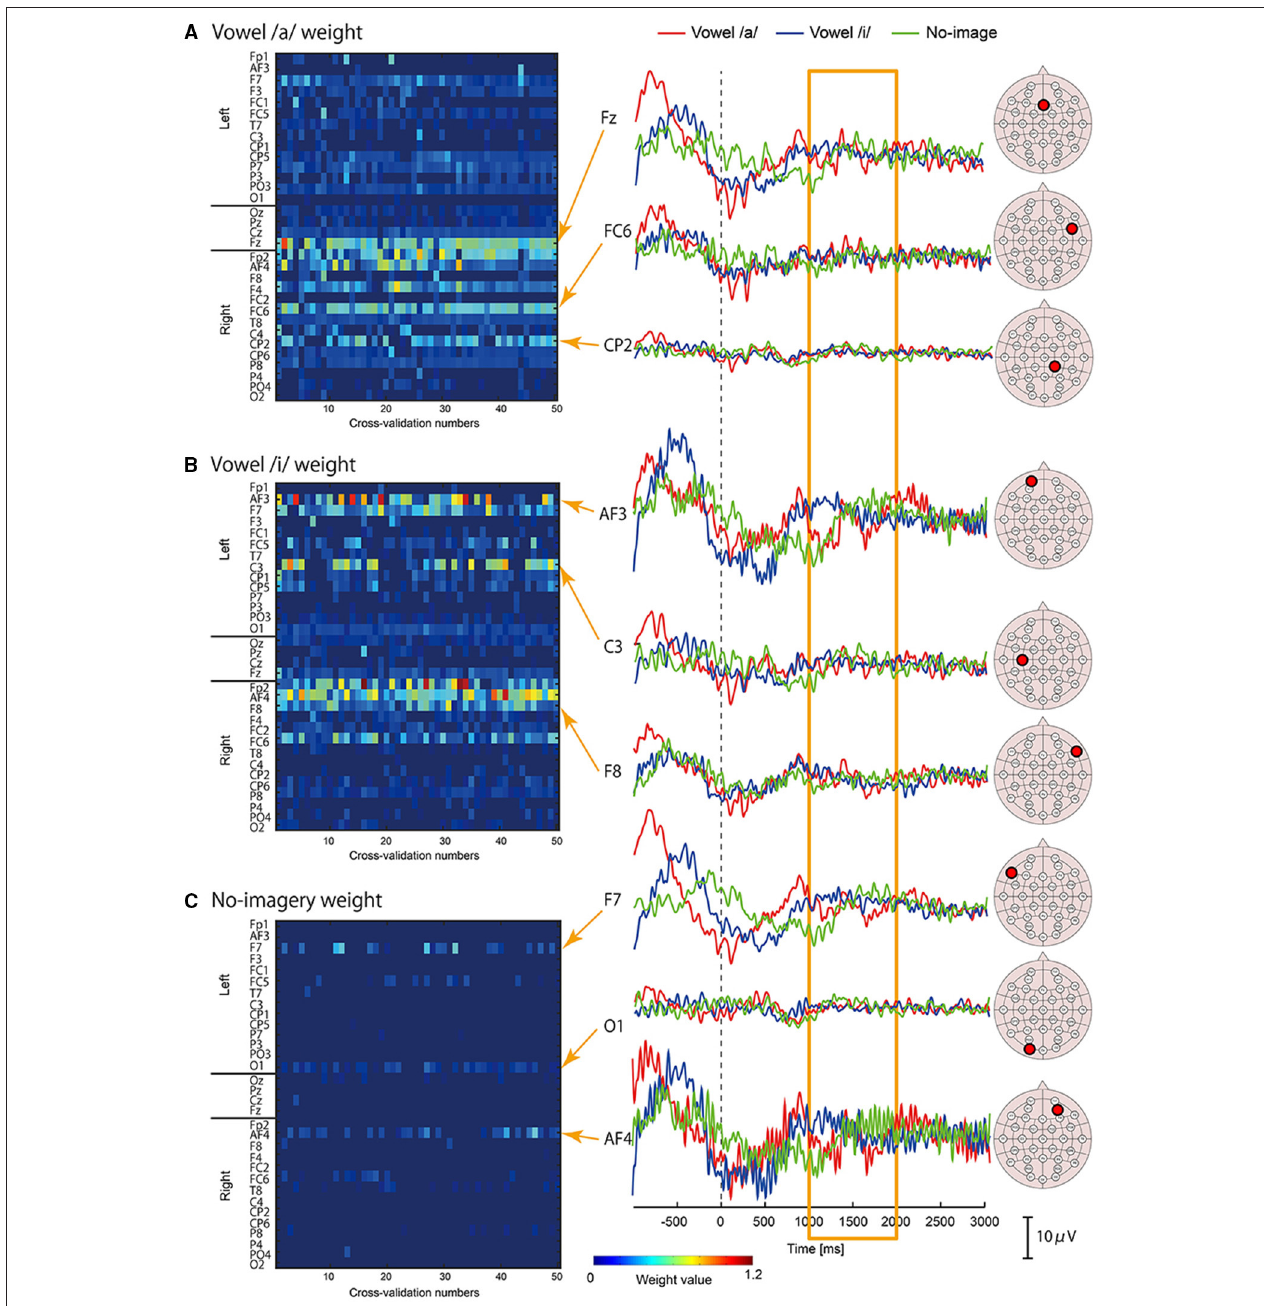
FIGURE 5 | Examples of EEG sensor signals in a participant who showed the highest accuracy. Left panel: Color maps of mean weight values of all sensors for each cross-validation analysis calculated by classifier for vowel /a/ (A) , vowel /i/ (B) , and no-imagery (C) . Right panel: Frequently selected sensors with high mean weight values (FSHV-sensors) were selected from the color maps and mean time series signals across trials were plotted. Red lines represent signals during vowel /a/ task, blue lines represent vowel /i/ task, and green lines represent no-imagery task. Signals from 1 to 2s after the auditory stimuli (orange box) were used for classification analyses. EEG sensor positions of the FSHV-sensors are shown beside each signal plot.